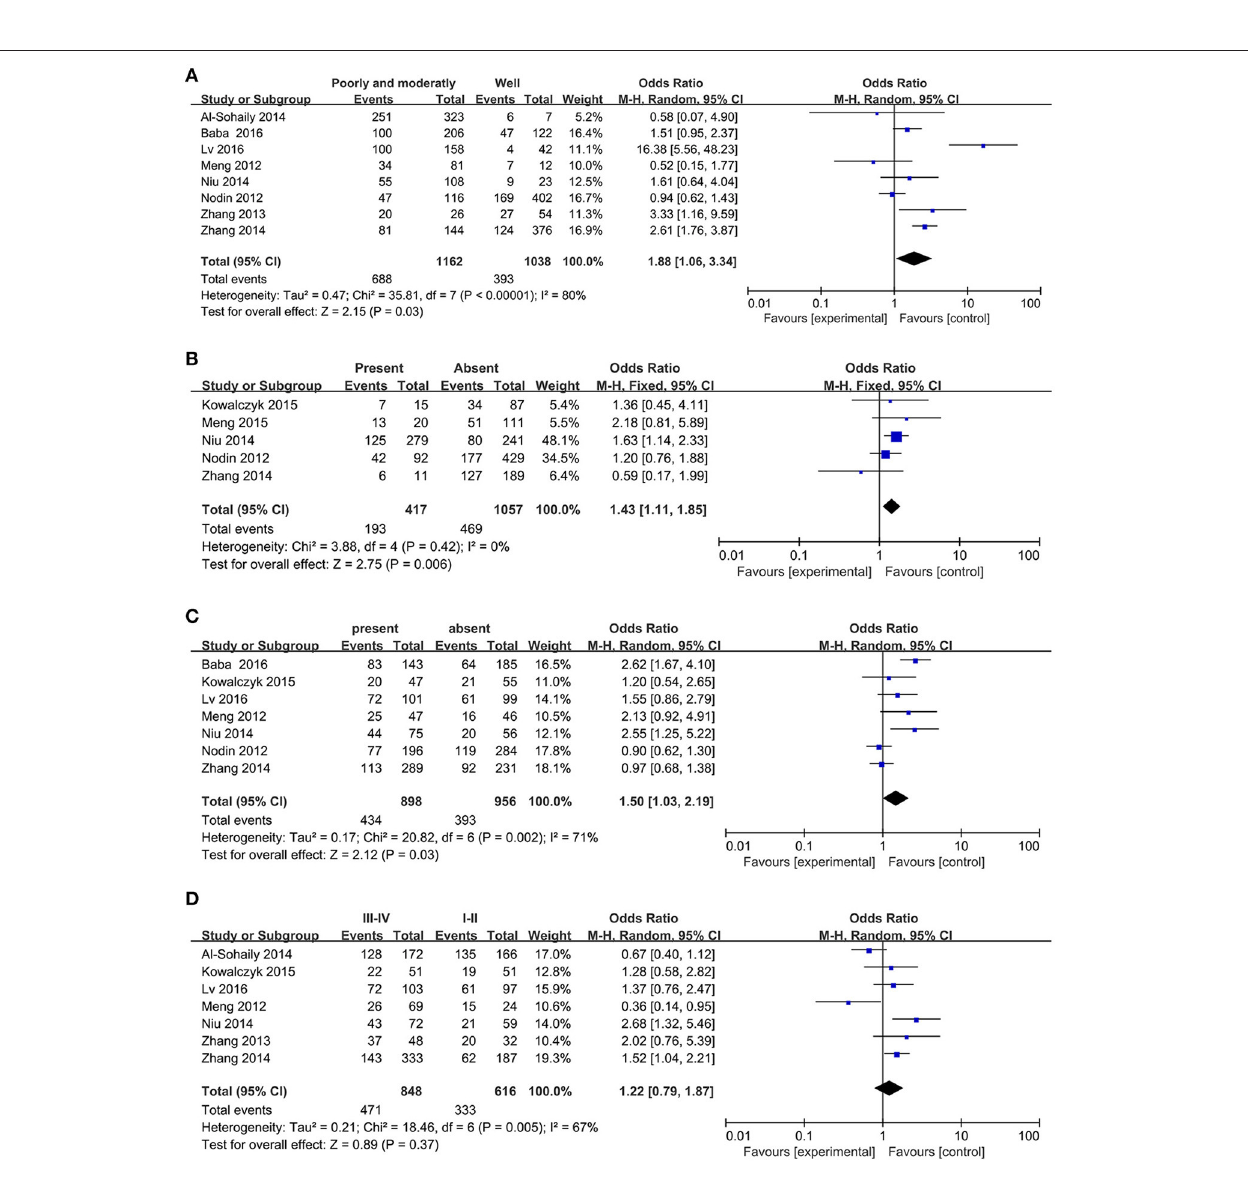
Frontiers in Physiology | www.frontiersin.org